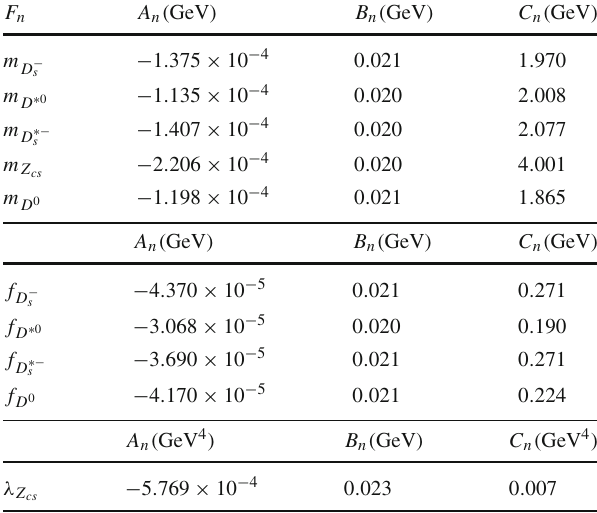
Table 3 Fit parameters for the mass and meson-current coupling con- stant of D